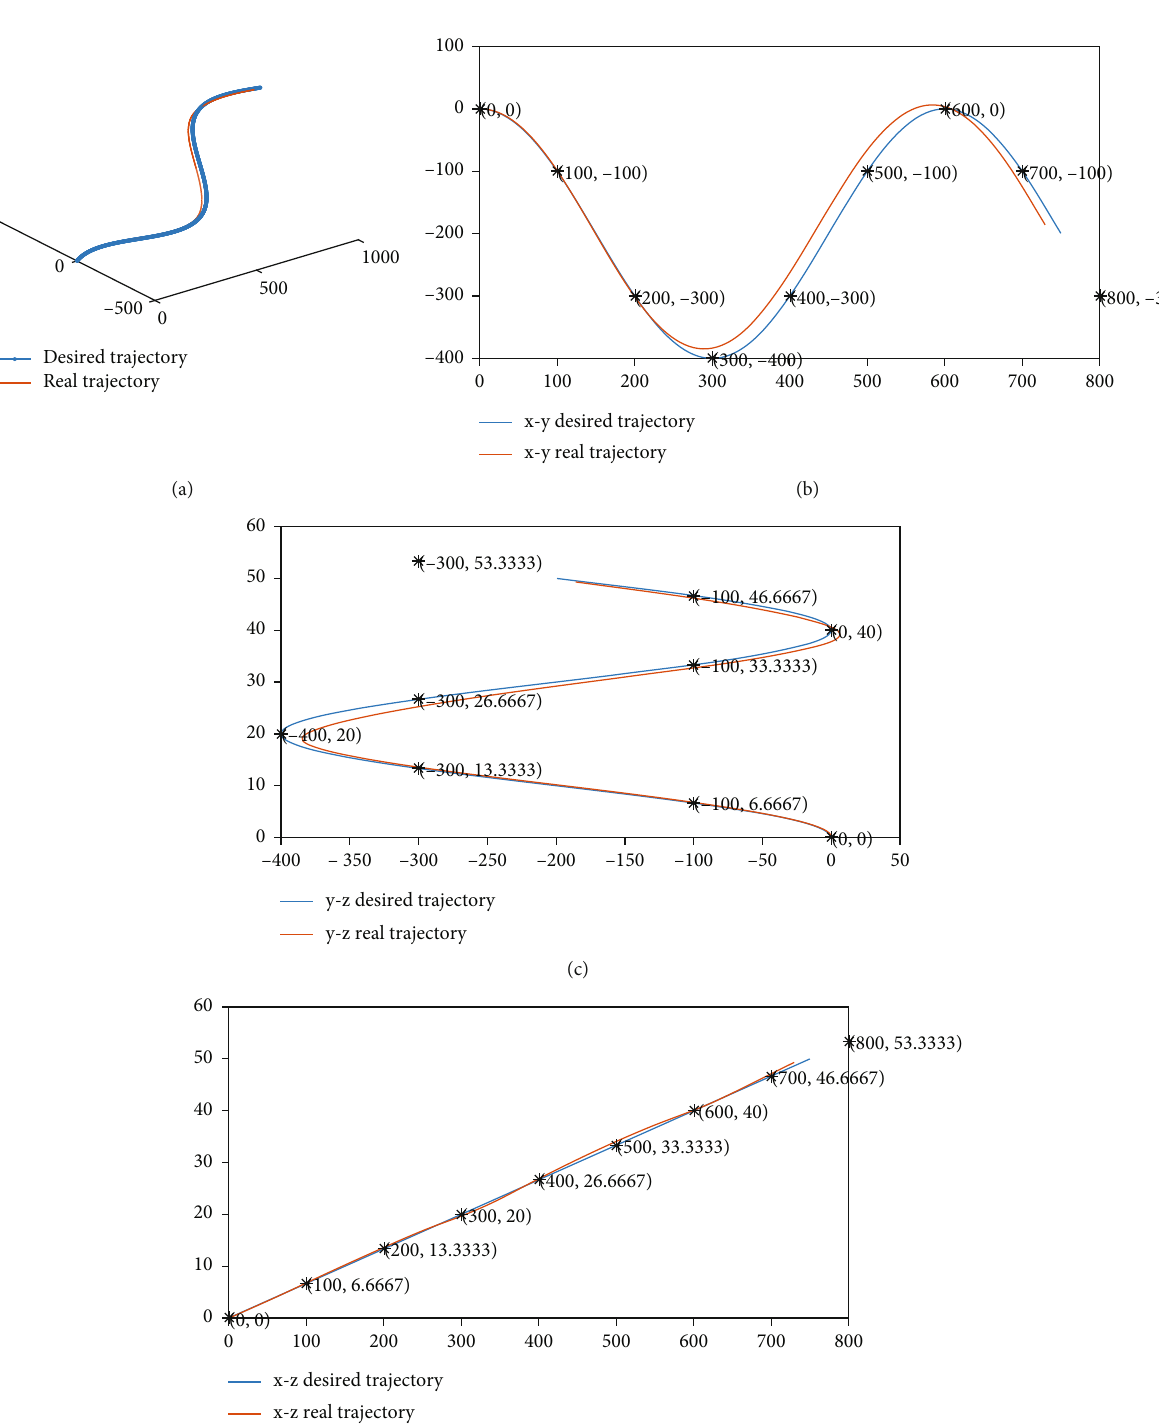
Figure 16: PID control trajectory: (a) in the 3D space; (b) in the x - y plane; (c) in the y - z plane; (d) in the x - z